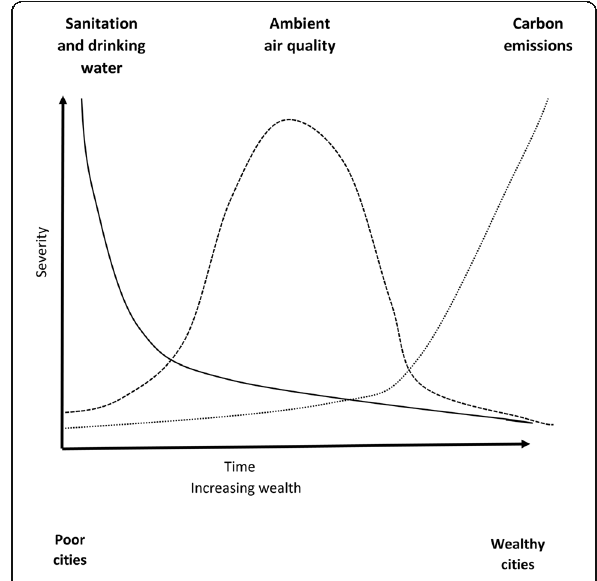
Fig. 3 The urban environmental transition. As cities get wealthier over time, the type of environmental burdens they face change systematically [33,